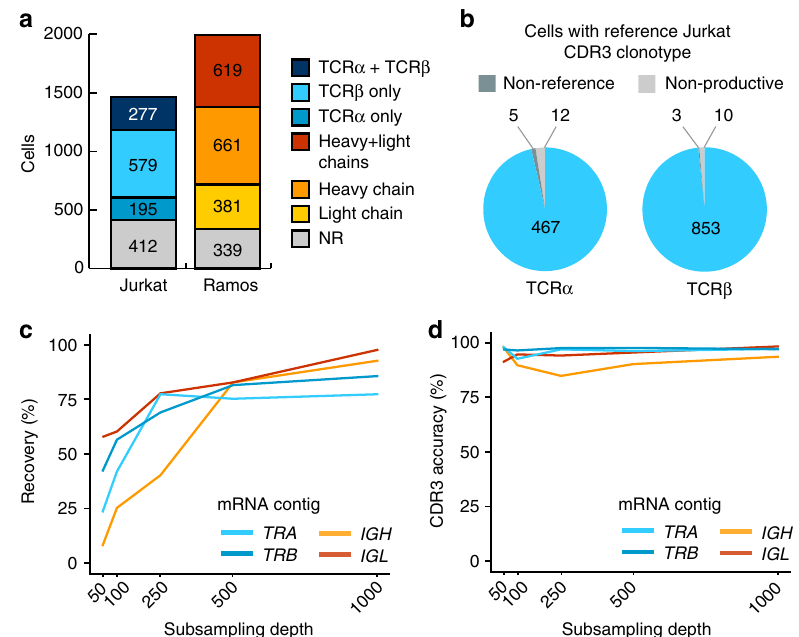
Fig. 3 Validation of antigen – receptor assembly. a Number of cells assigned productive TCR α and TCR β chains for Jurkat cells ( n = 1463) or productive heavy and light chains for Ramos cells ( n = 2000). Only receptor chains expressing the reference V and J gene combinations of Jurkat ( TRA : TRAV8-4, TRAJ3 ; TRB : TRBV12-3, and TRBJ1-2 ) or Ramos ( IGH : VH4-34, IGHJ6 ; IGL : IGLV2-14, and IGLJ2 ) were assigned. NR no receptor. b CDR3 accuracy